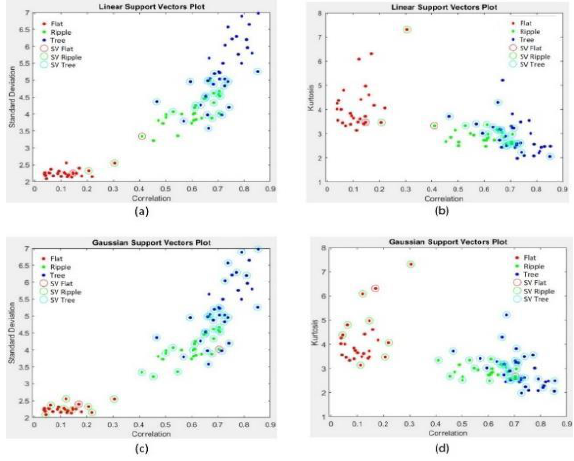
Figure 4. Feature plots using a linear kernel with Correlation/Standard Dev. (a) and Correlation/Kurtosis features (b), and (c)/(d) using the same features with a Gaussian kernel. For the remaining tests six combinations of the textural variables used in the SVM classification which are shown in Table 1.